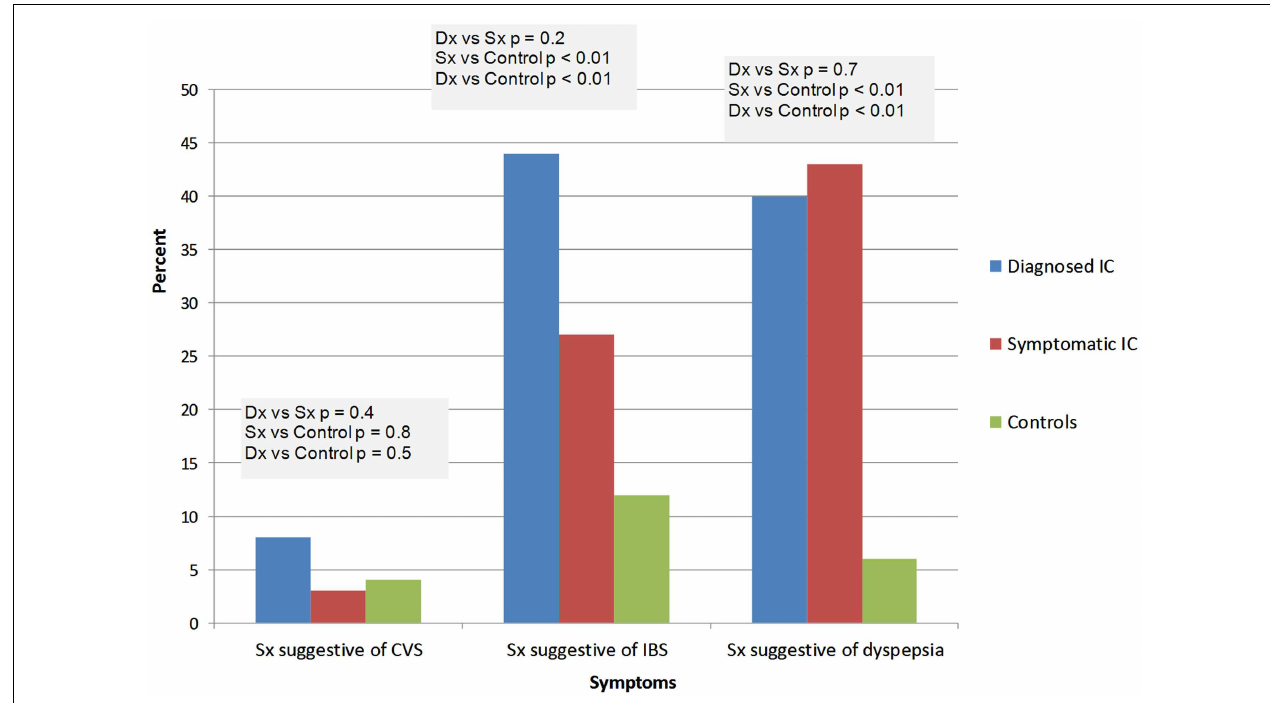
who have symptoms of IC/BPS based on NIDDK criteria (symptomatic IC). CVS, cyclic vomiting syndrome; IBS, irritable bowel